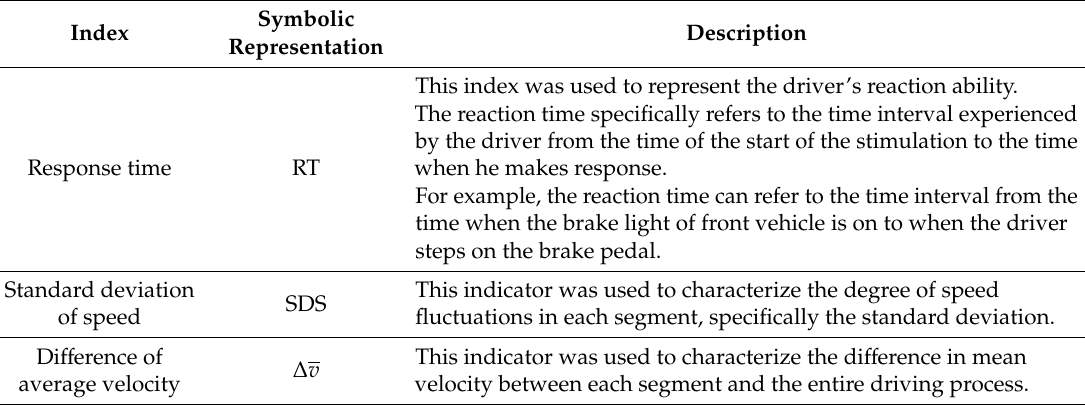
Table 2. Descriptions of the cluster